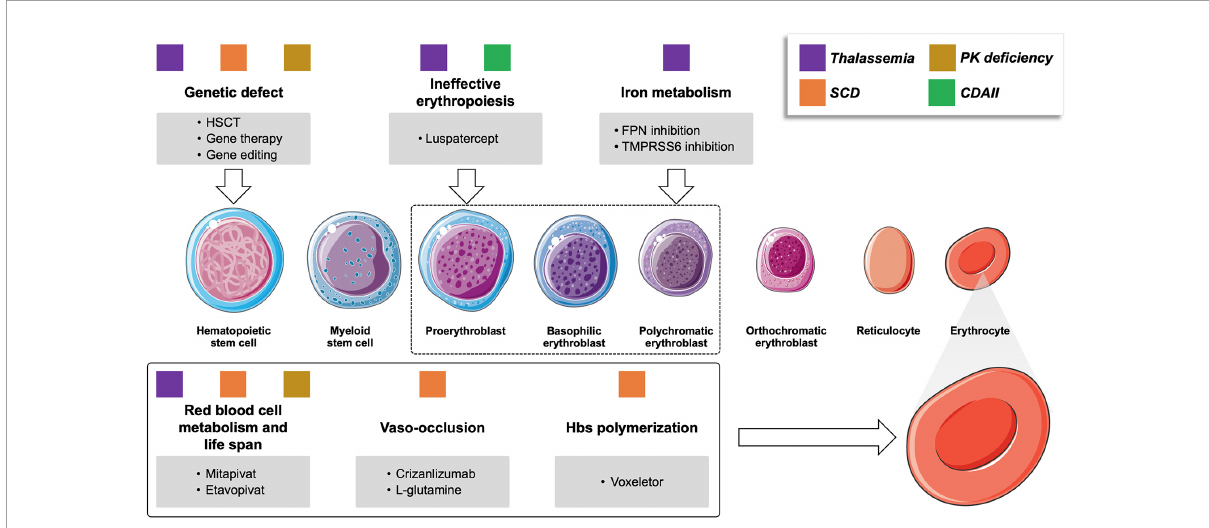
FIGURE1 Novel drugs for rare congenital anemias and their targets. Colored squares represent the different conditions that may benefit of the various compounds under investigation. PK pyruvate kinase; CDAII congenital dyserythropoietic anemia type II; SCD sickle cell anemia; HSCT, hematopoietic stem cell transplant; PK, pyruvate kinase; FPN,